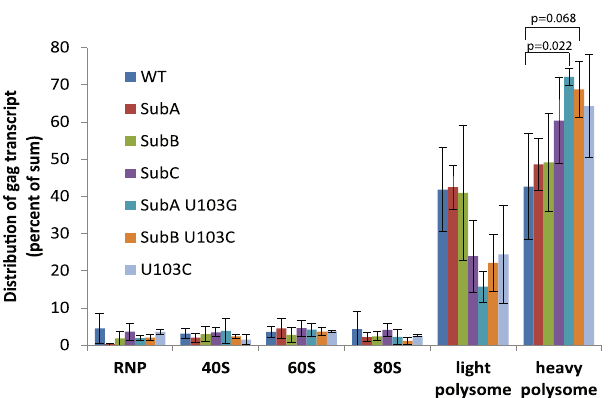
Figure 5. Addition of U103 substitution to monomer 5 ′ UTRs significantly increased HIV polysomes. Statistical analysis of replicate ribosome profile experiments with each molecular clone measuring distribution of gag RNA by RT-qPCR. The percentage in each RNP is the average ± standard error of three independent experiments and statistically significant differences relative to WT denoted in